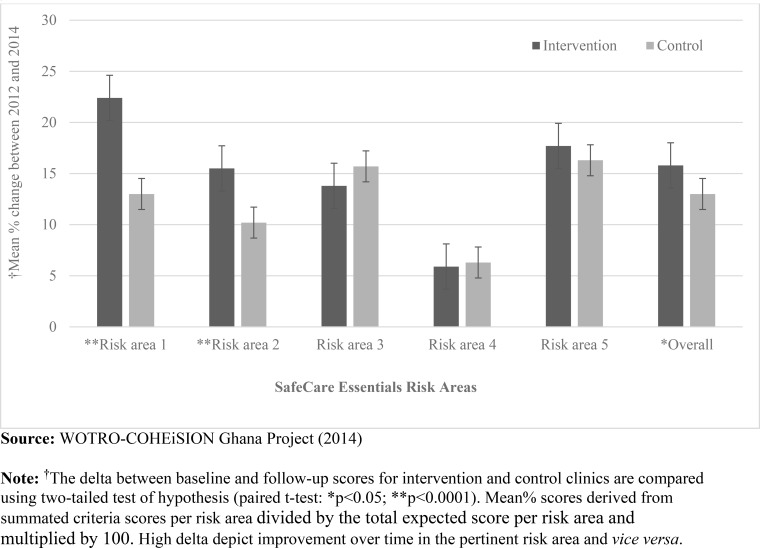
Error bars showing average deltas in patient risk areas between 2012 and 2014.
Legend: Risk area 1 (Leadership processes and accountability); Risk area 2 (Competent and capable workforce); Risk area 3 (Safe environment for staff and patients); Risk area 4 (Clinical of patients); Risk area 5 (Quality improvement and safety).